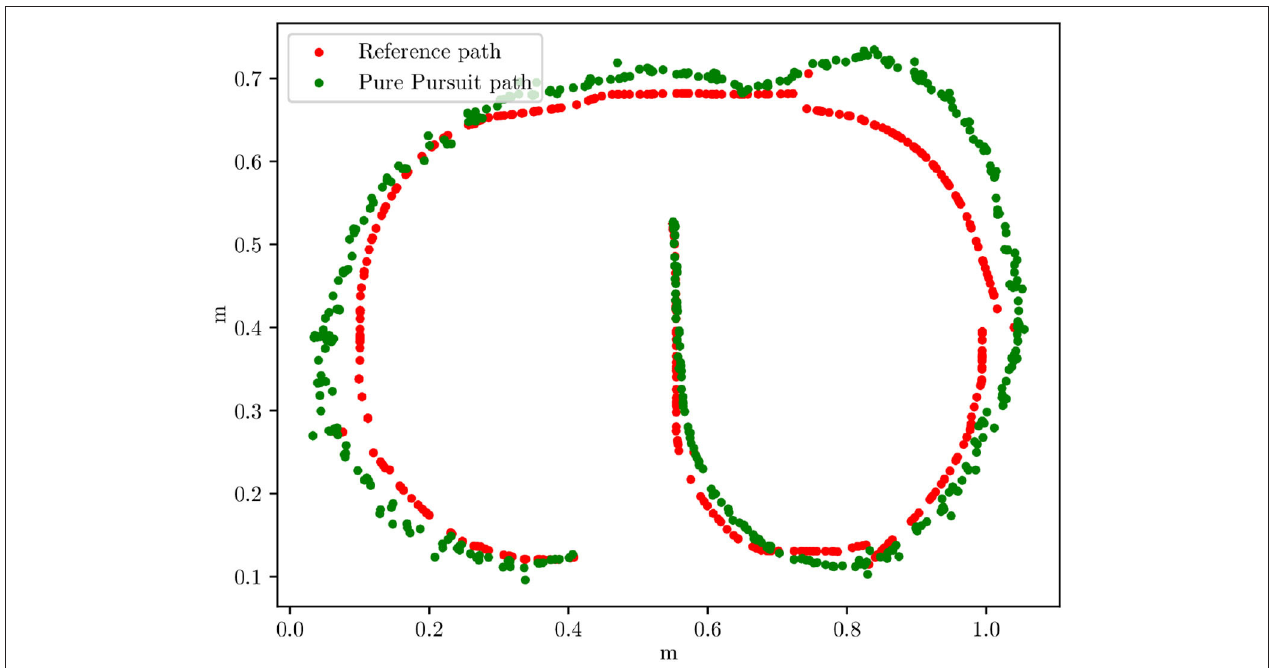
FIGURE 10 | X/Y graph of a track driven with the real truck chassis and pure pursuit. Given in red is the ideal reference path. detection and following has proven to be a viable test